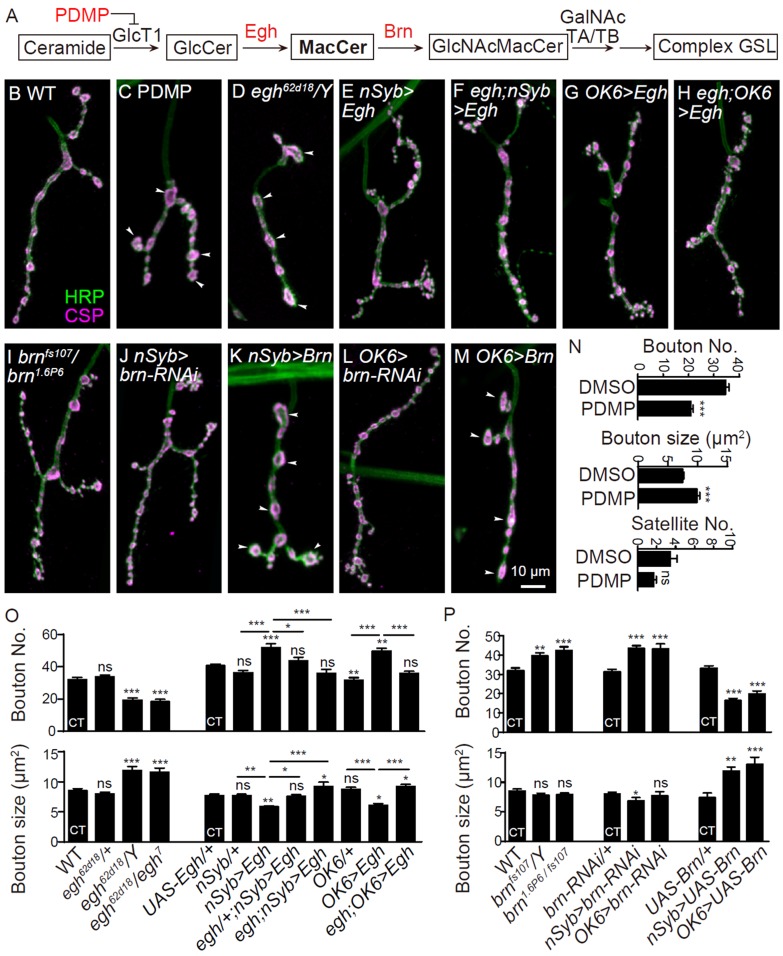
GSL synthases Egh and Brn bi-directionally regulates NMJ growth presynaptically(A) GSL synthesis pathway in Drosophila.(B–M) Images of NMJ4 co-stained with anti-HRP (green) and anti-CSP (magenta) in wild type (B), larvae treated with 0.5 mg/ml D, L-threo-PDMP (C), egh62d18/Y (D), UAS-Egh/+; nSyb-Gal4/+ (E), egh62d18/Y; UAS-Egh/+; nSyb-Gal4/+ (F), UAS-Egh/OK6-Gal4 (G), egh62d18/Y; UAS-Egh/OK6-Gal4 (H) brn fs107/brn1.6P6 (I), UAS-brn-RNAi/+; nSyb-Gal4/+ (J) nSyb-Gal4/UAS-brn (K), UAS-brn-RNAi/OK6 Gal4 (L), and OK6-Gal4/+; UAS-brn/+ (M). Scale bar: 10 μm; Arrowheads point at large boutons. (N–P) Quantifications of total bouton number, bouton size, and satellite bouton number of NMJs in different genotypes or treated with PDMP. ‘CT’ denotes corresponding control in each multiple comparison.*p<0.05; **p<0.01, ***p<0.001 by one-way ANOVA with Tukey post hoc tests; n ≥ 12 larvae; error bars: s.e.m.10.7554/eLife.38183.006Figure 2—source data 1.Numerical data for the statistical graphs.